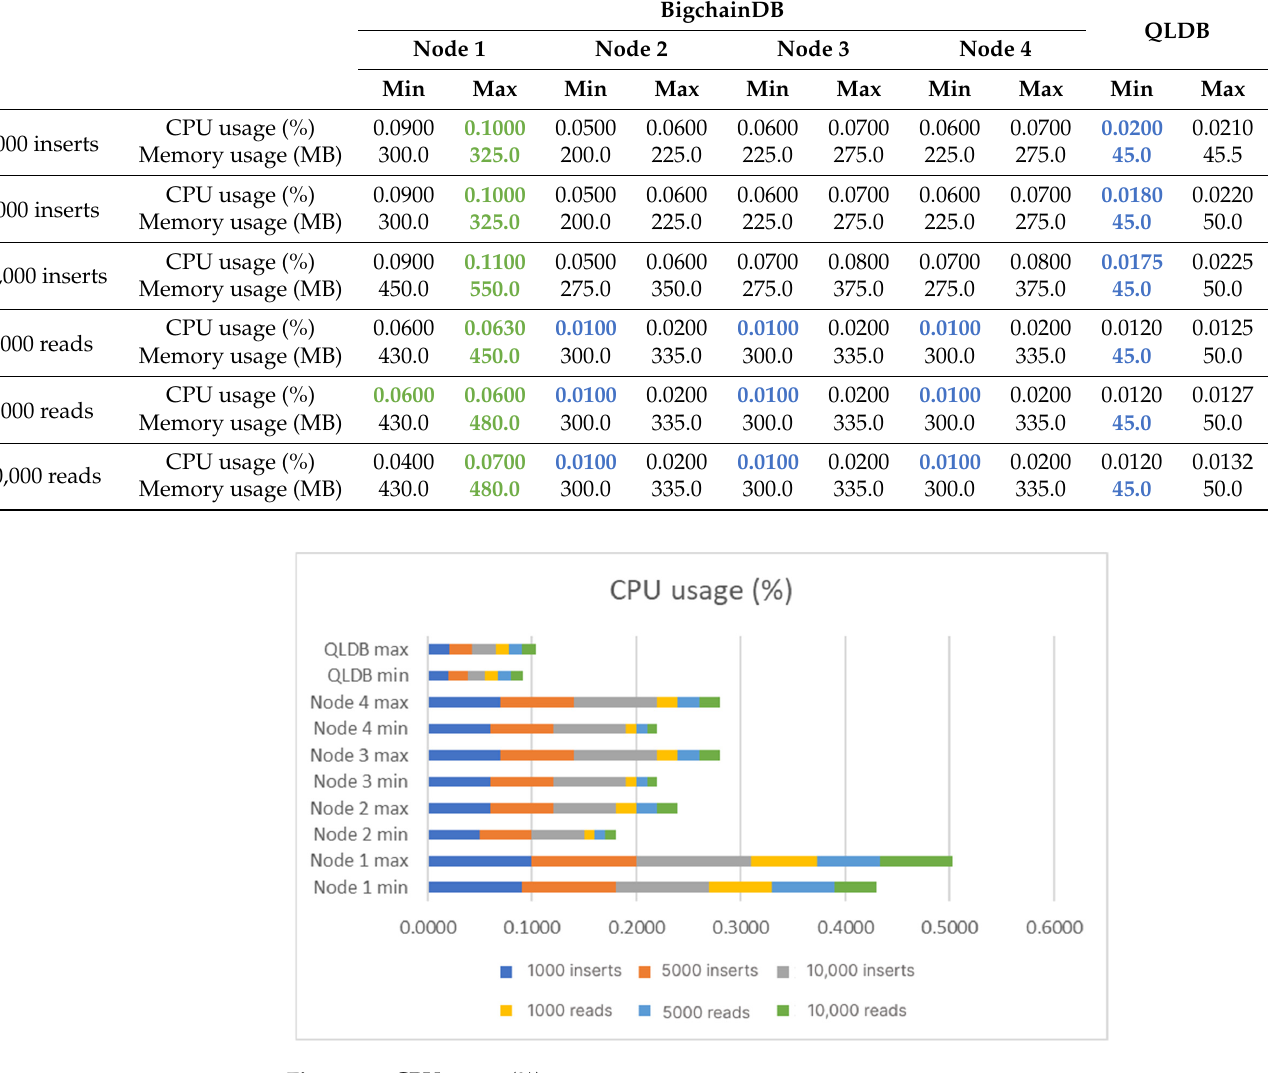
Figure 30. CPU usage (%).